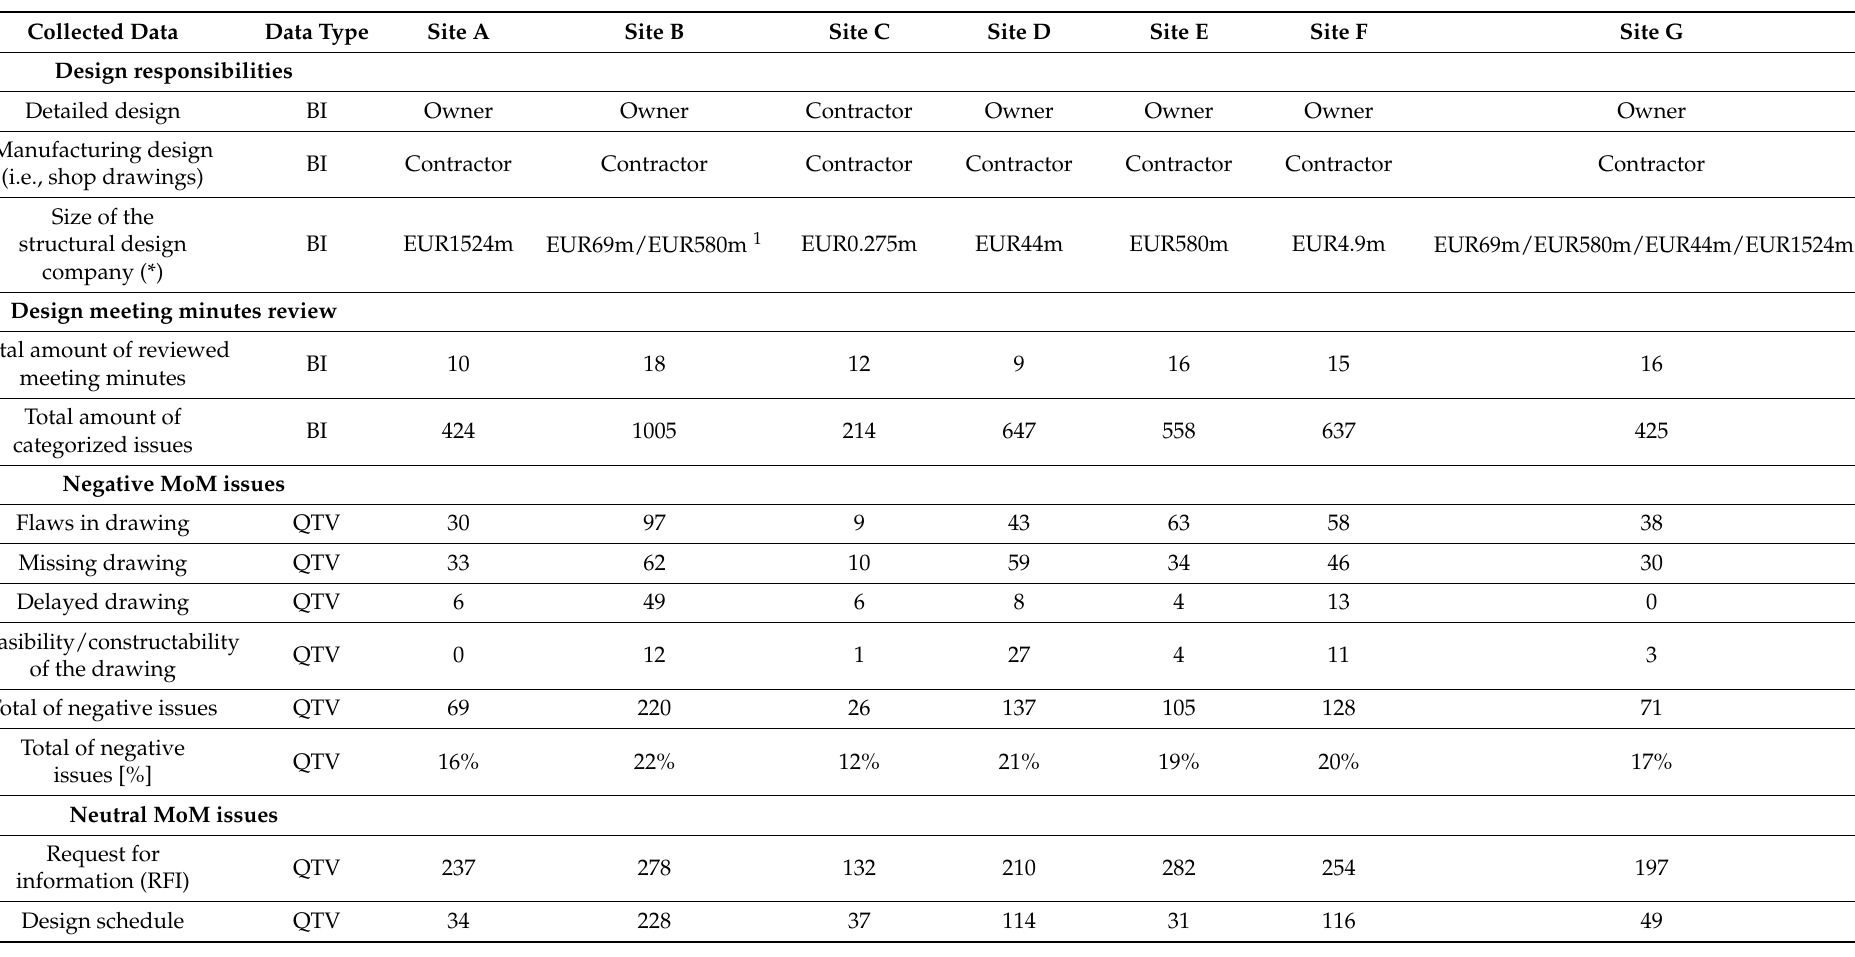
Table 1. Summary table of design quality—background information and meeting minute issues. Abbreviations: Background information = BI; Quantitative =